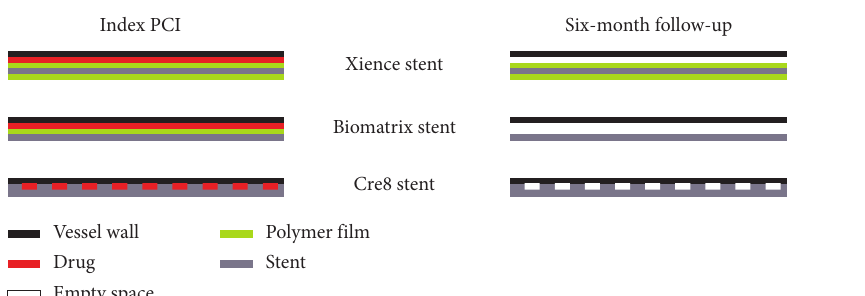
Figure 3: Schematic representation of the structural differences among the tree types of stents and their different interaction with the vessel wall during PCI and at 6-month